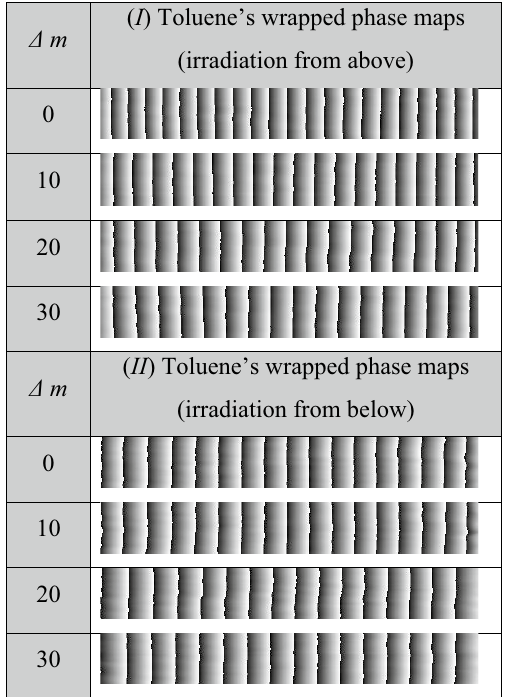
Figure 3. The wrapped phase maps of the interferograms shown in Fig. 2.